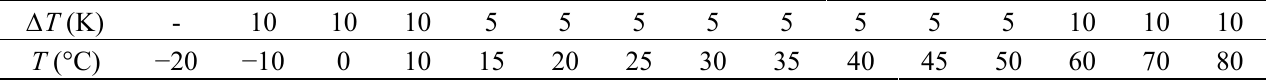
Table 2. Inhomogeneous temperature